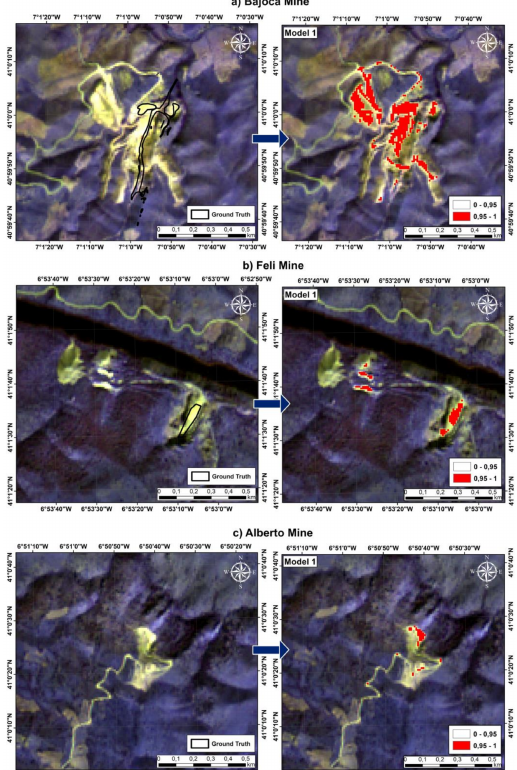
Figure 7. Li distribution probability map of Remote Sensing Model 1 for the three training areas: ( a ) Bajoca Mine, ( b ) Feli Mine, ( c ) Alberto Mine. High potentials are in red. Ground truths are marked with black polygons.